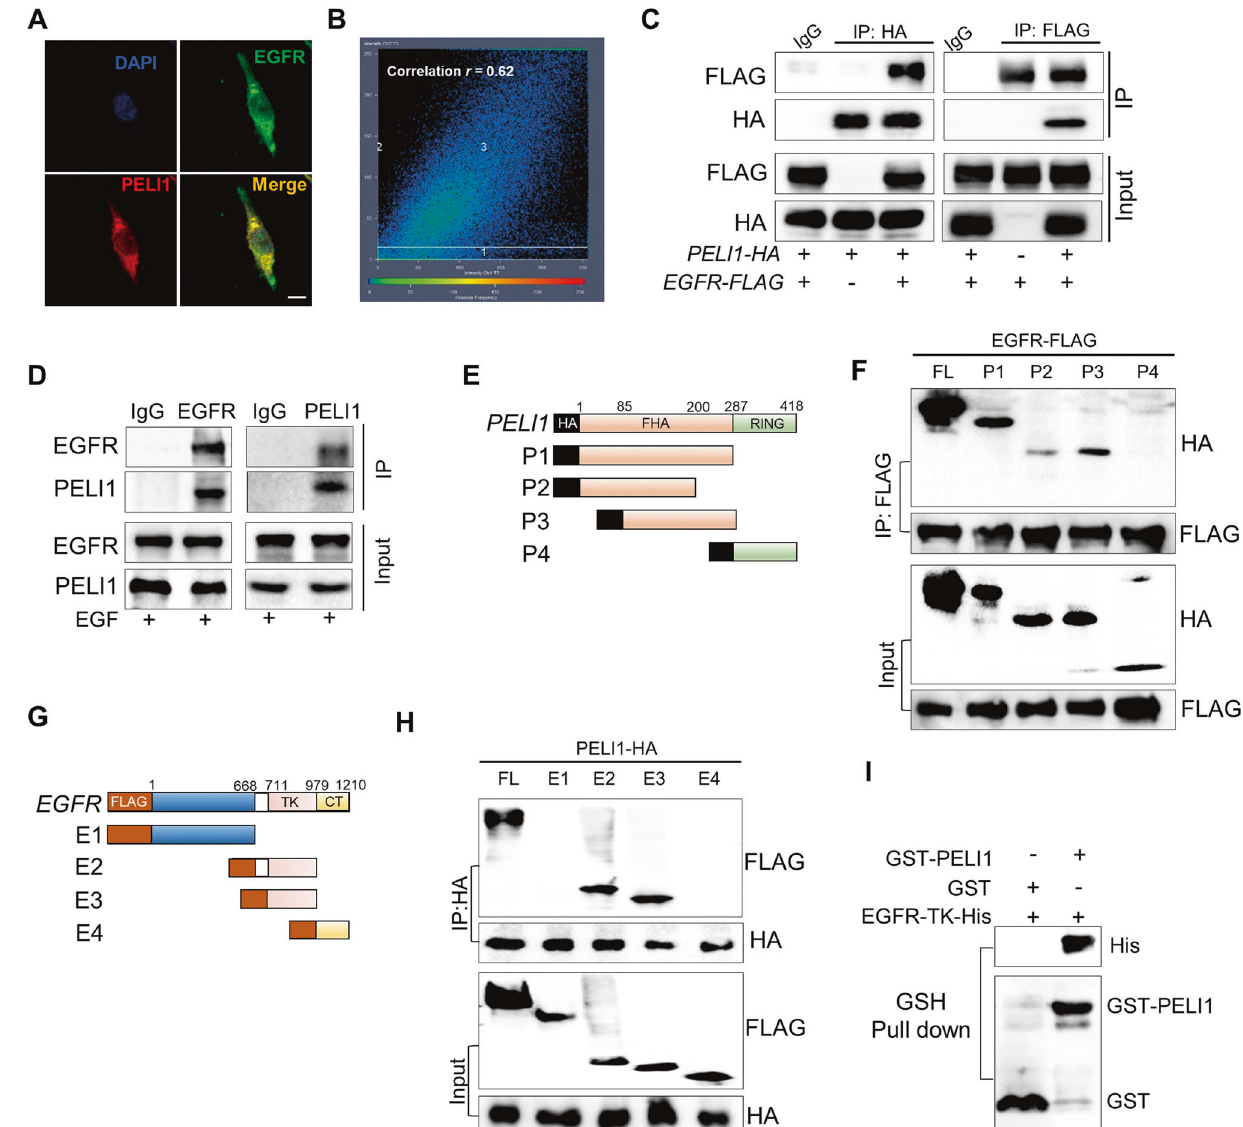
Co-IP assay. HEK293T/17 cells were co-transfected with pCDNA3.1-HA- PELI1 and pLVX-FLAG- EGFR plasmids. The cells were harvested and subjected to immunoprecipitated with anti-HA and anti-FLAG antibodies respectively. Similar Co-IP analysis with normal IgG were performed as control. D Co-IP analysis of endogenous PELI1 and EGFR in MDA-MB-231 cells. The cell extracts were immunoprecipitated with anti-IgG, anti-EGFR and anti-PELI1 antibodies, respectively, upon EGF (100 ng/ml) stimulation. E The sketch map of the deletion mutant regions of PELI1. F Co-IP analysis of PELI1 mutants binding to EGFR. HEK293T/17 cells were co-transfected with PELI1 deletion mutants (HA tagged) and pLVX-FLAG- EGFR plasmids, and IP analysis was performed with anti-FLAG antibody. G The sketch map of the deletion mutant regions of EGFR. H Co-IP analysis of EGFR regions binding to PELI1. HEK293T/17 cells were co-transfected with EGFR deletion mutants (FLAG-tagged) and pCDNA3.1-HA- PELI1 plasmids, and IP analysis was performed with ani-HA antibody. I GST-pull down assay of the direct correlation between PELI1 and